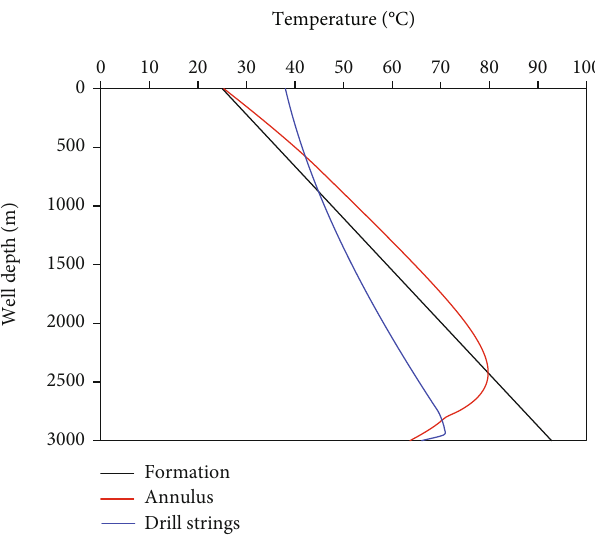
Figure 4: Temperature pro fi le of inside drillstrings, annulus, and